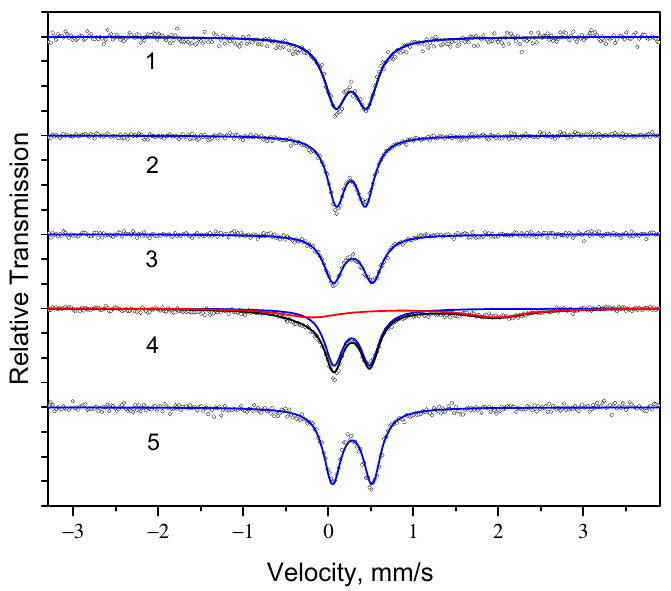
Figure 4. Mössbauer spectra of complexes 1·0.5H 2 O , 2·H 2 O , 3 , 4·H 2 O , 5·1.5H 2 O (1–5).